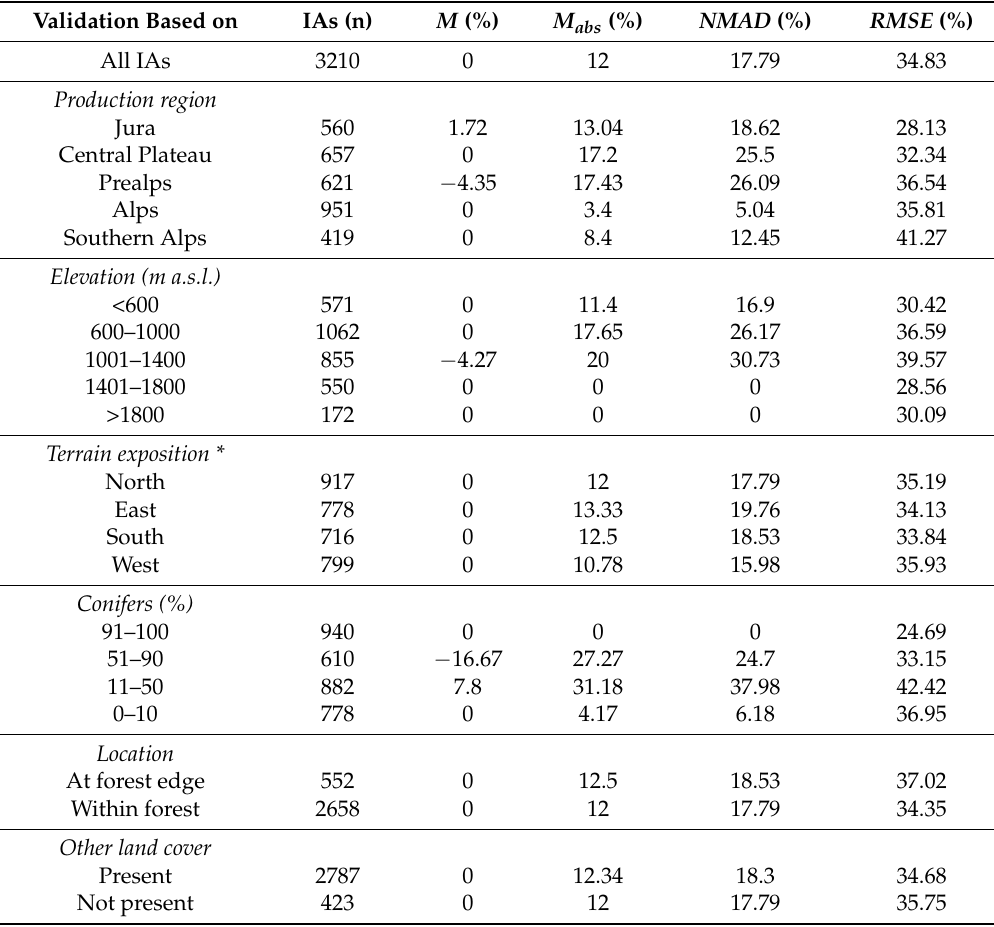
Table A1. Measurements of agreement in predicted and observed broadleaved fractions in the IAs and the High Resolution Layers (HRL forest 2012) 20-m forest type map using Median ( M ), absolute Median ( Mabs ), Normalized Median Absolute Deviation ( NMAD ), and Root Mean Squared Error ( RMSE ). The validation incorporates all IAs, NFI production regions, NFI elevation levels, NFI stand composition (percentage of conifers), terrain exposition (aspect), location, and the presence of other land cover